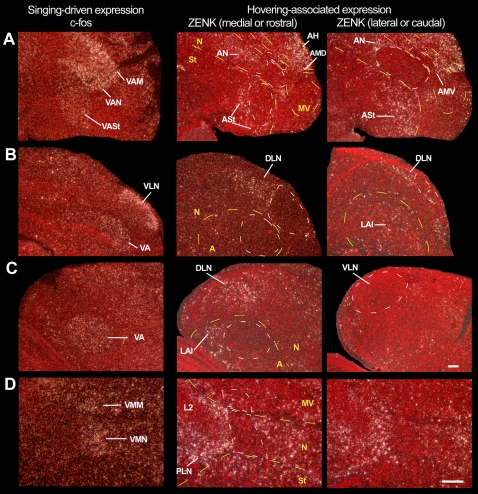
High power images of IEG activation in hummingbird vocal nuclei during singing and in adjacent movement-associated areas during hopping.A. Anterior vocal nuclei adjacent to ASt, AN, and AMV in sagittal sections. B. DLN adjacent to VLN [and LAI to VA] in coronal sections. C. LAI adjacent to VA [and DLN to VLN] in sagittal sections. D. VMN [as well as VMM] adjacent to activated areas near L2 in sagittal sections. The c-fos expression in vocal nuclei (first column) is of male that sang for 30 min interspersed with flying and feeding; c-fos is shown for its high contrast in vocal nuclei relative to the surrounding non-vocal areas. The hovering-associated expression patterns (left two columns) are from the hemisphere opposite of the covered eye and ear of males that hovered in a plexiglass cage. Anterior is right, dorsal is up for sagittal sections; medial is left, dorsal is up for frontal sections. The left most sections are either lateral (A, C, and D) or caudal (B) to that shown in the middle column. Different background red color is due to different cresyl violet staining intensities. Note that similar to budgerigar MO and NAO (Fig. 10Ab and Fig. S6A), the two analogous hummingbird pallial anterior vocal nuclei (VAM and VAM) are very close such that the IEG expression does not distinguish the brain subdivision boundary well. Yellow dashed lines-brain subdivision boundaries; white dashed lines–vocal nuclei boundaries, only highlighted for some images so that other sections can be viewed as is; boundaries were determined from Nissl stain and adjacent sections hybridized with FoxP1 (Fig. 11Ac and Fig. S7C). Scale bars, 200 µm.